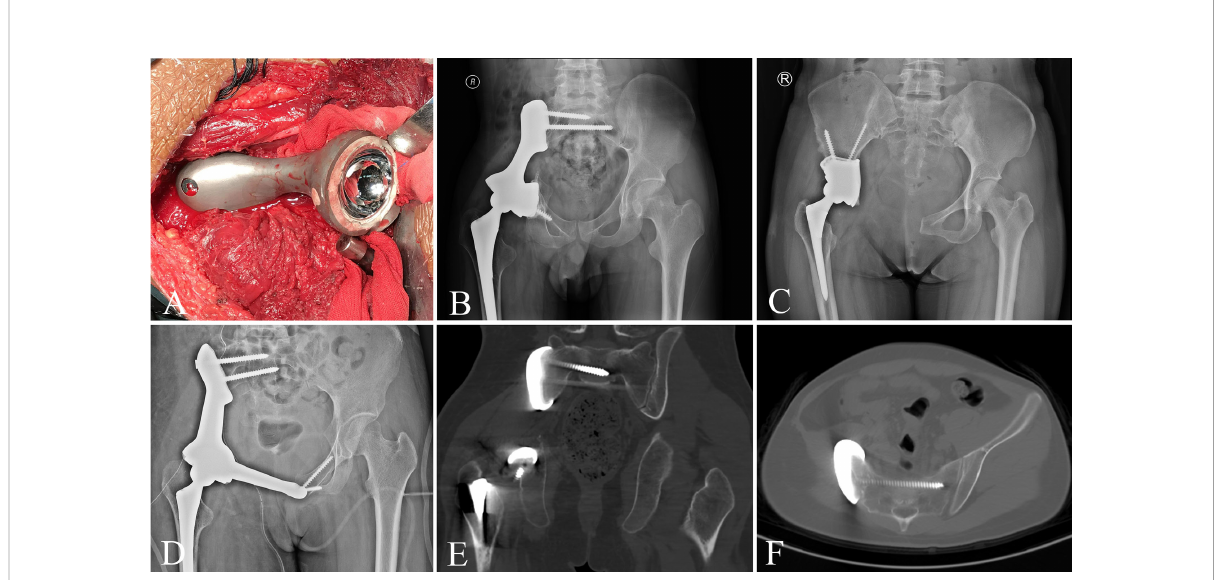
FIGURE 2 (A) The customized 3D-printed prosthesis was implanted following tumor resection. (B – D) Pelvic radiograph after 3D-printed prosthesis reconstruction. (E, F) CT scan shows that the bone is tightly bound to the